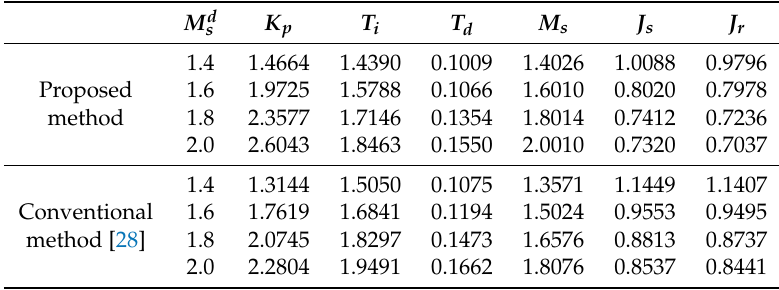
Table 8. Proportional-integral-derivative parameters, M s , and SAE values in the servo design using Equations (46) and (48), respectively.